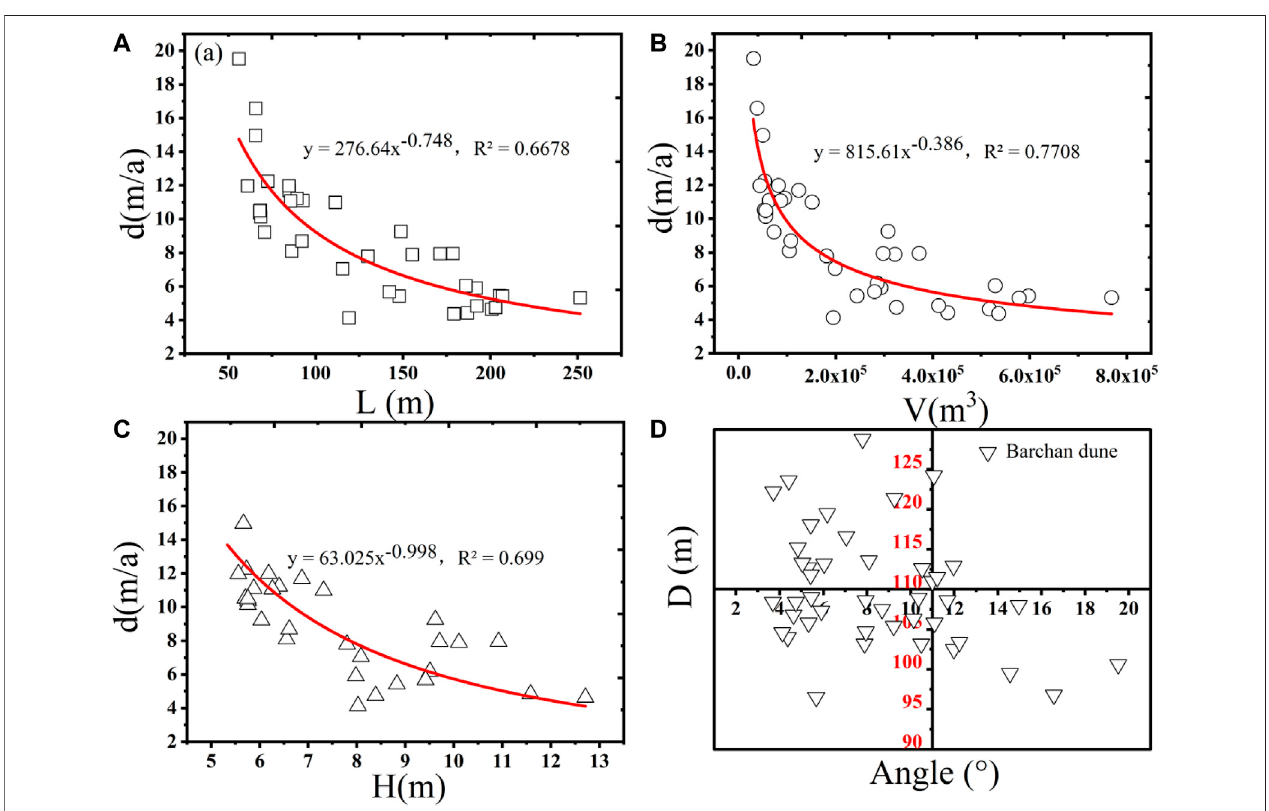
FIGURE 7 | The correlations between the length of the dune, the height of the dune, the volume of the dune, and the direction of movement.